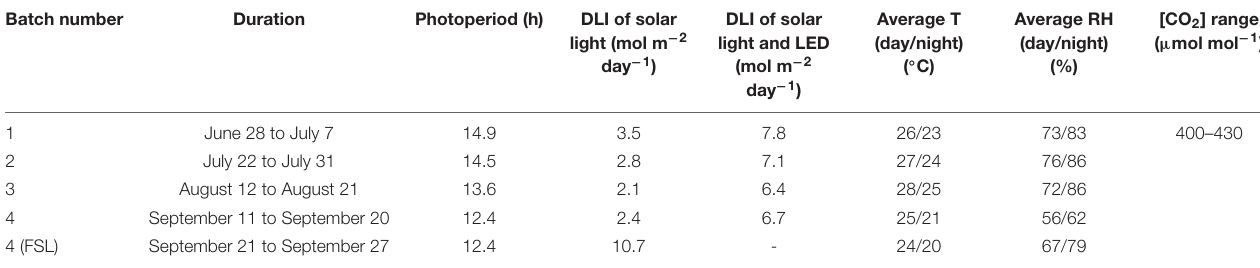
TABLE 1 | Growth conditions during four batches of the experiment. Batch number